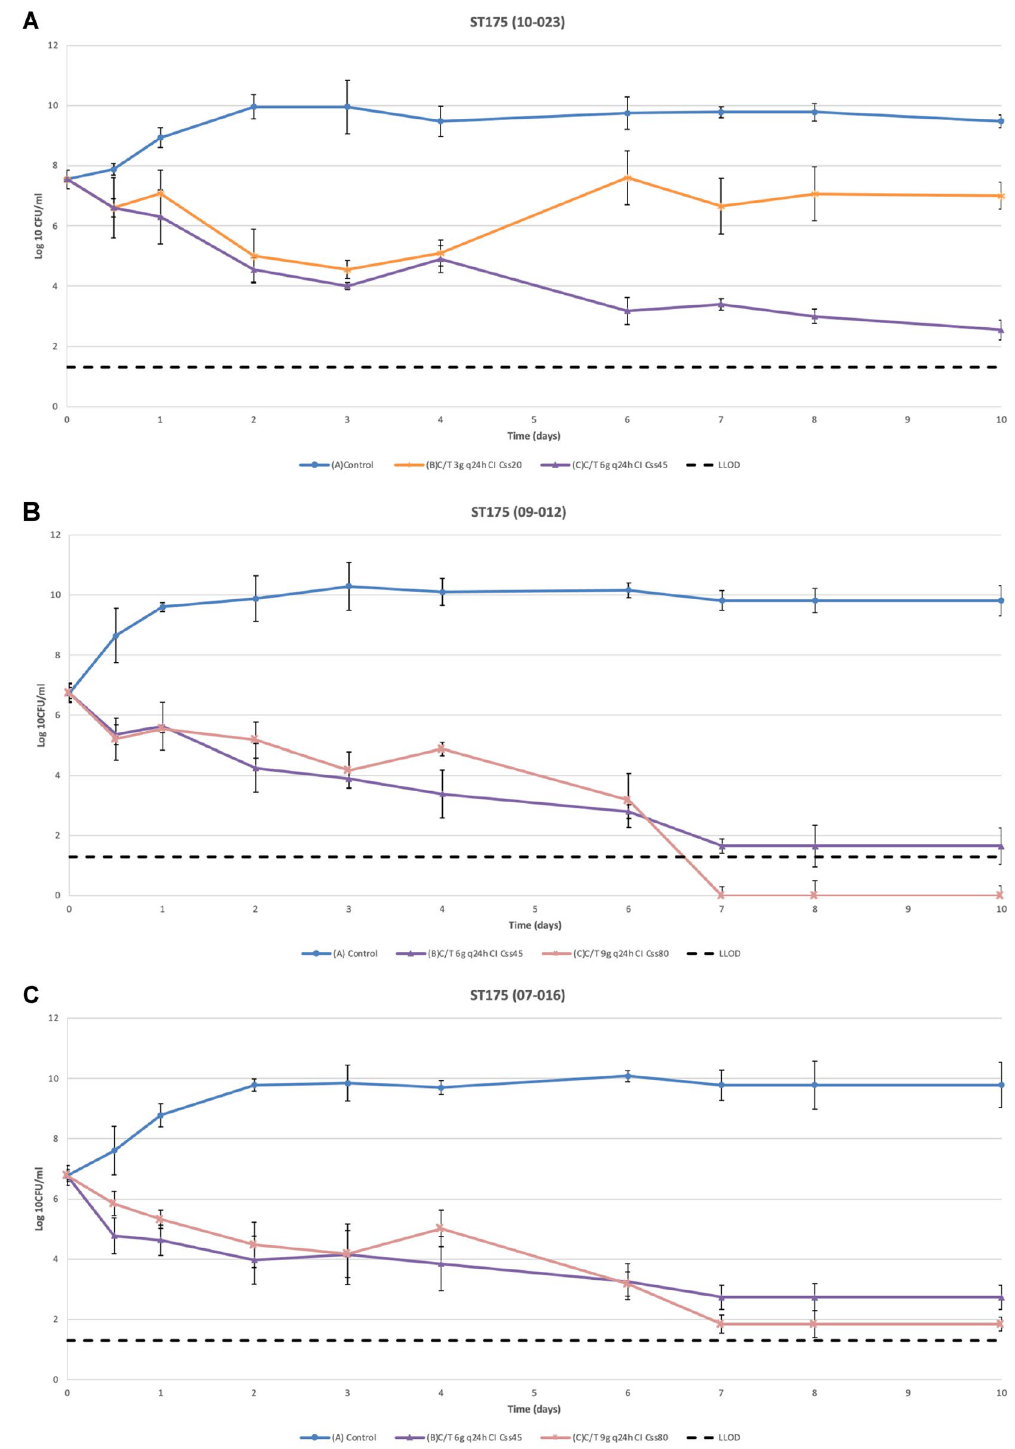
Figure 2. Mean reduction in bacterial density during the 10-day HFIM assays with ST175 (10-023), ST175 (09-012) and ST175 (07-016) isolates treated with different Css of C/T (20, 45 and 80 mg/L) in CI. Respective C/T MIC values of 2, 8 and 16 mg/L. C/T, ceftolozane/tazobactam; CI, continuous infusion; Css, steady-state concentration; LLOD, lower limit of detection; MIC, minimum inhibitory